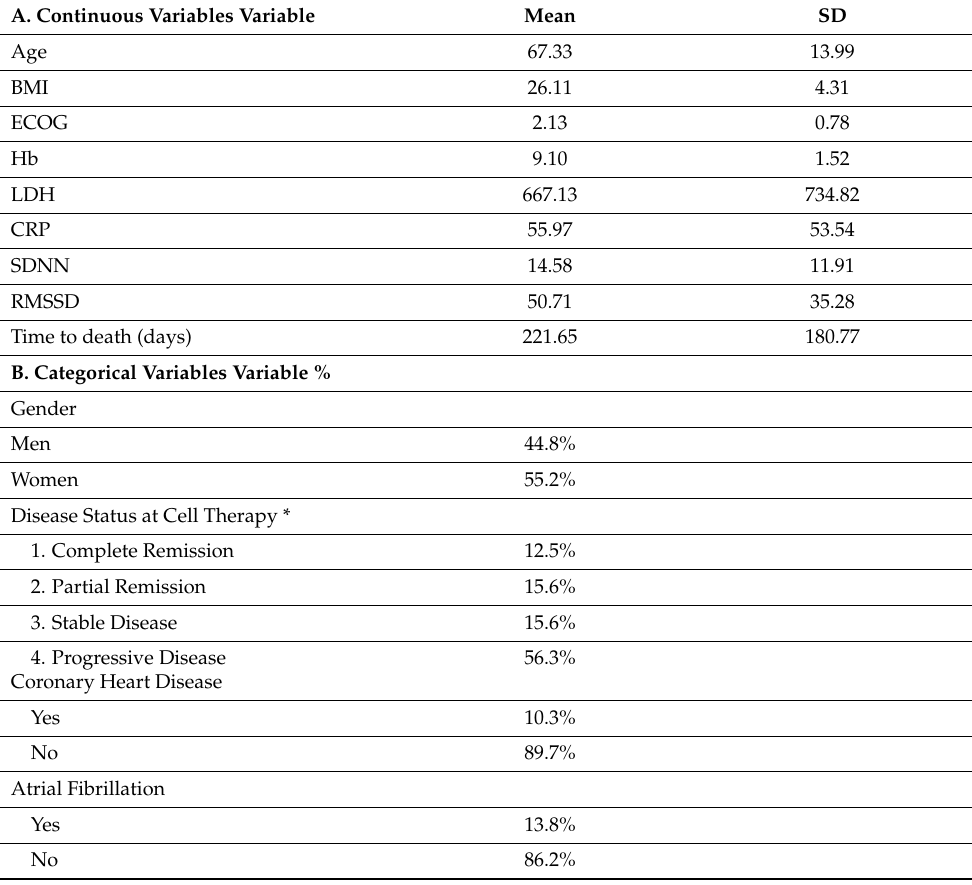
Table 1. Relapsed/refractory diffused large B-cell lymphoma